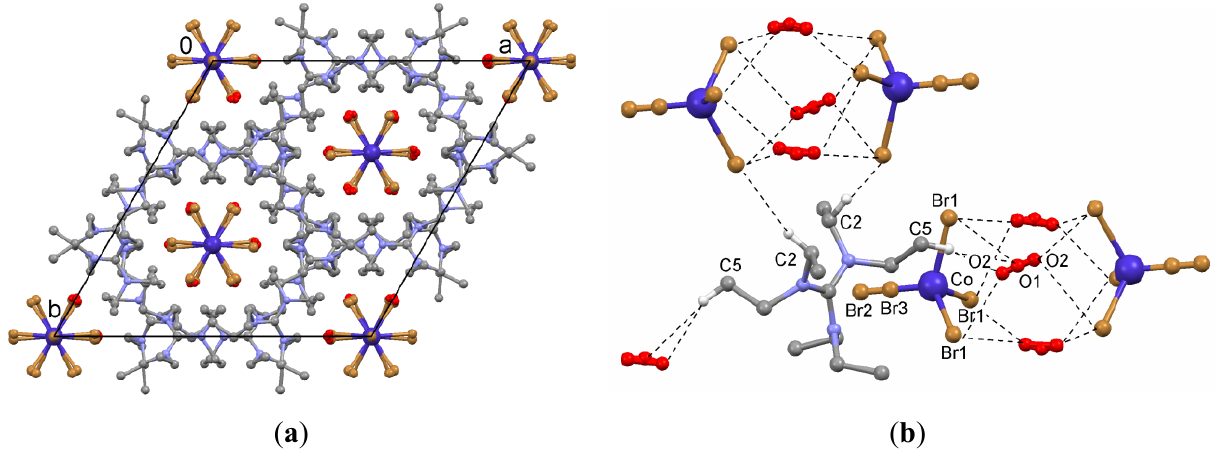
Figure 4. ( a ) Packing diagram of hexaethylguanidinium tetrabromocobaltate(II)/bromide